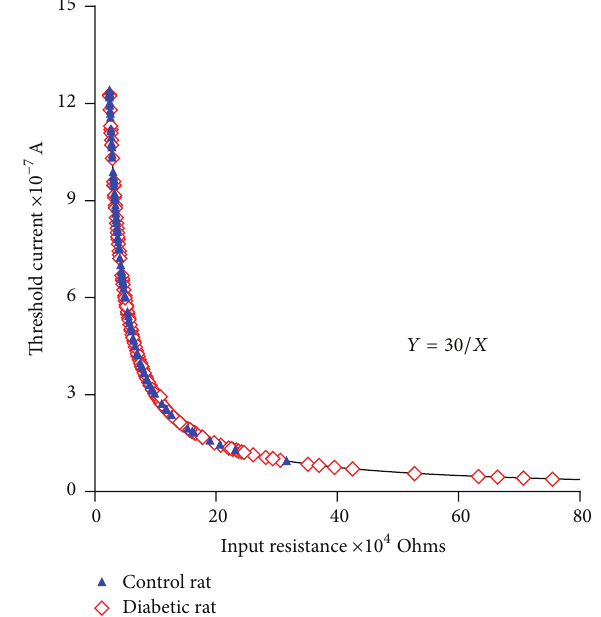
Figure 7: Input resistance versus threshold current relationship in the control rats and diabetic rats. The relationship obtained in the papillary muscle of the heart of the control rats and the rats with diabetes. The continuous line corresponds to the theoretical equilateral hyperbola, 𝑌 = 30/𝑋 . Filled symbols: control rats; unfilled symbols: diabetic